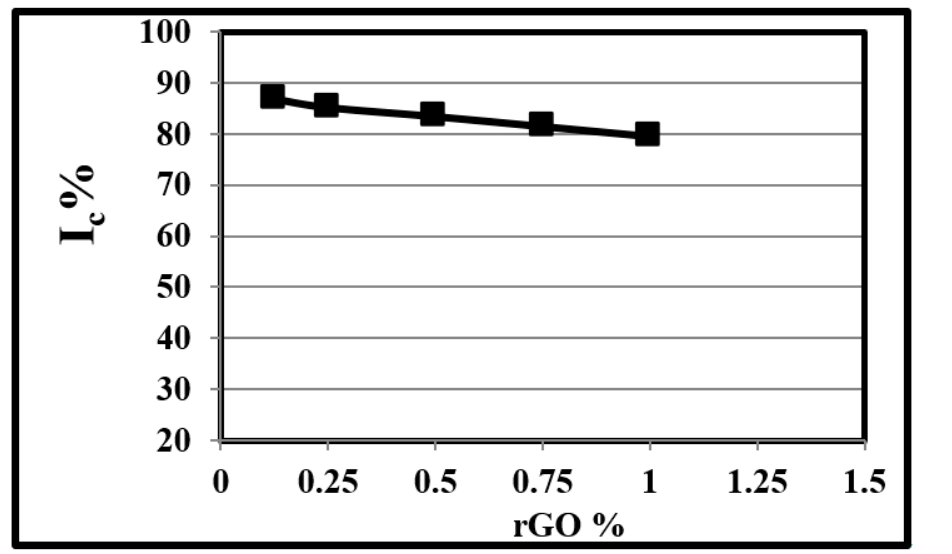
Figure 2. Effect of rGO wt.% on the crystallinity index of rGO. Table 2. Effect of rGO wt.% on I c of rGO at 20°C for 1 h.